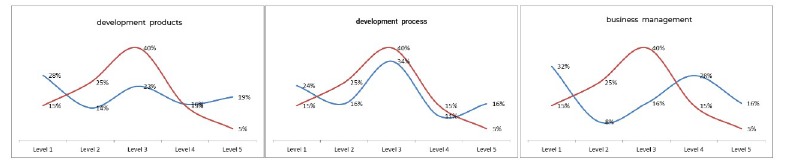
Fig 8. The proportion of development products, development process, and business management personnel